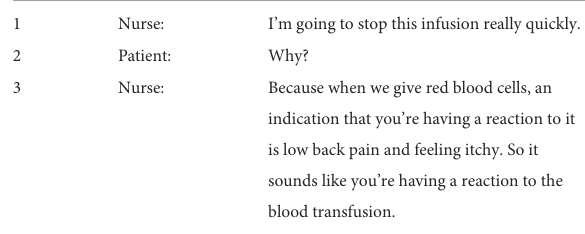
TABLE 2 Sample dialogue from S1 demonstrating evaluation of the